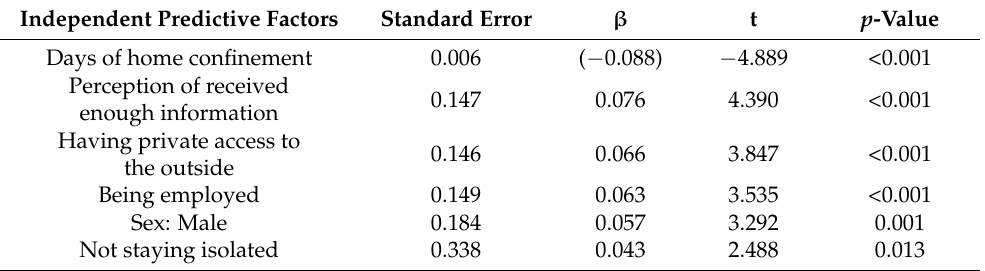
Table 3. Multiple linear regression analysis of independent predictive factors for a higher life satisfaction. Independent Predictive